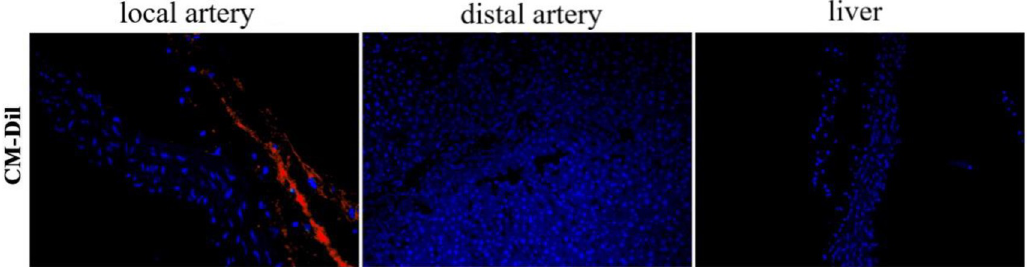
Fig 4. The distribution of HUCBSC in local artery, distal artery and liver. A small amount of HUCBSC can be seen in local artery (red), but not in distal artery or liver.